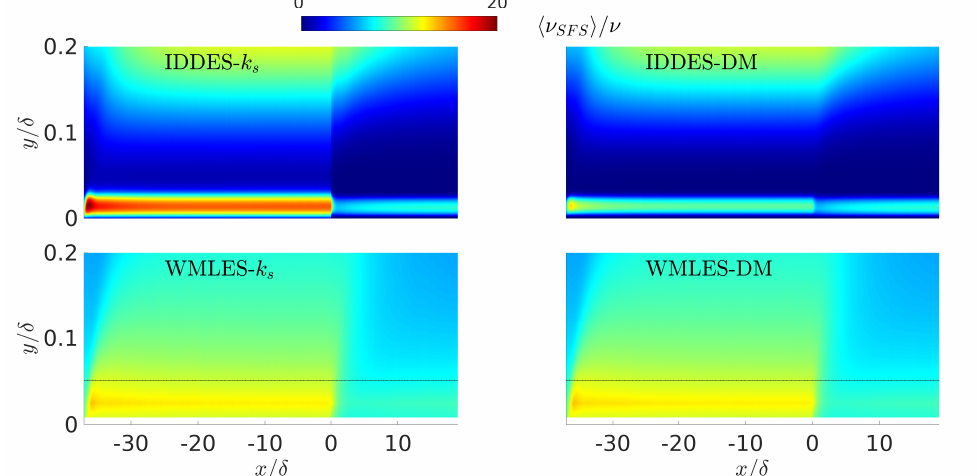
Figure 8. Contours of eddy viscosity normalized by the fluid viscosity. The horizontal dashed line indicates the location of the inner/outer layer interface for